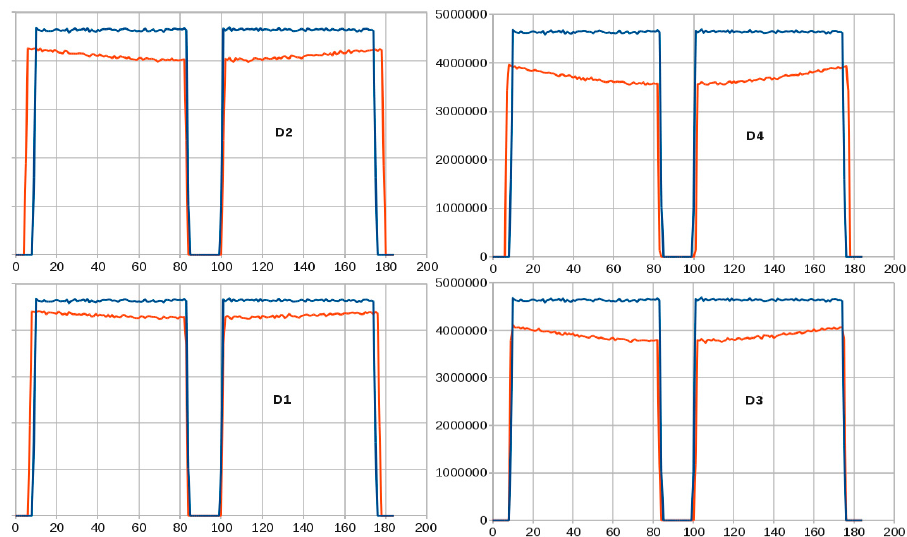
Figure 15. Computer simulations showing radiation profiles collected at detectors D1, D2 (before P1 hole), D3 and D4 (after P1 hole). Blue indicates the correct geometry, red indicates a P2 at z = 101.0 mm, so the distance between P1 and P2 is 1 mm too short. The vertical axis represents the simulated radiation flux (resulting from 10 9 input rays). The horizontal axis represents the horizontal radial distance (with the central hole in the middle).